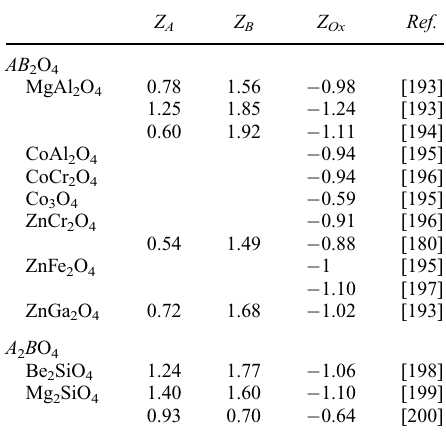
TABLE VIII (b) Effective Charges in Ternary